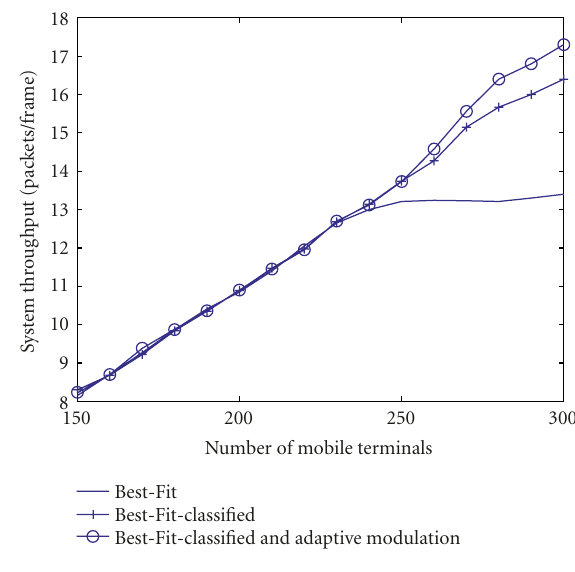
Figure 7: Multimedia system throughput comparison.